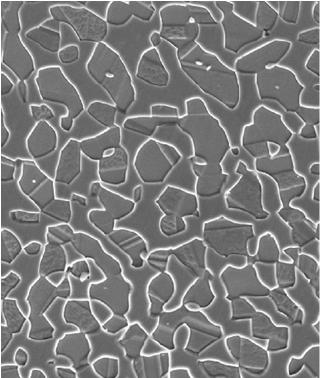
Figure 11: Duplex as received.